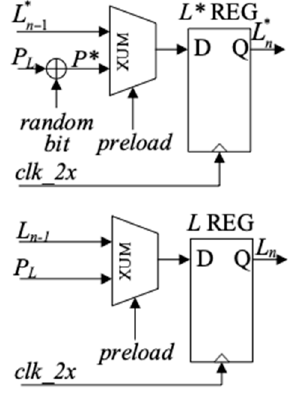
Figure 9. The schematic diagram of fault injection.